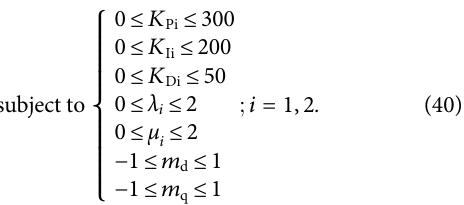
Frontiers in Energy Research |